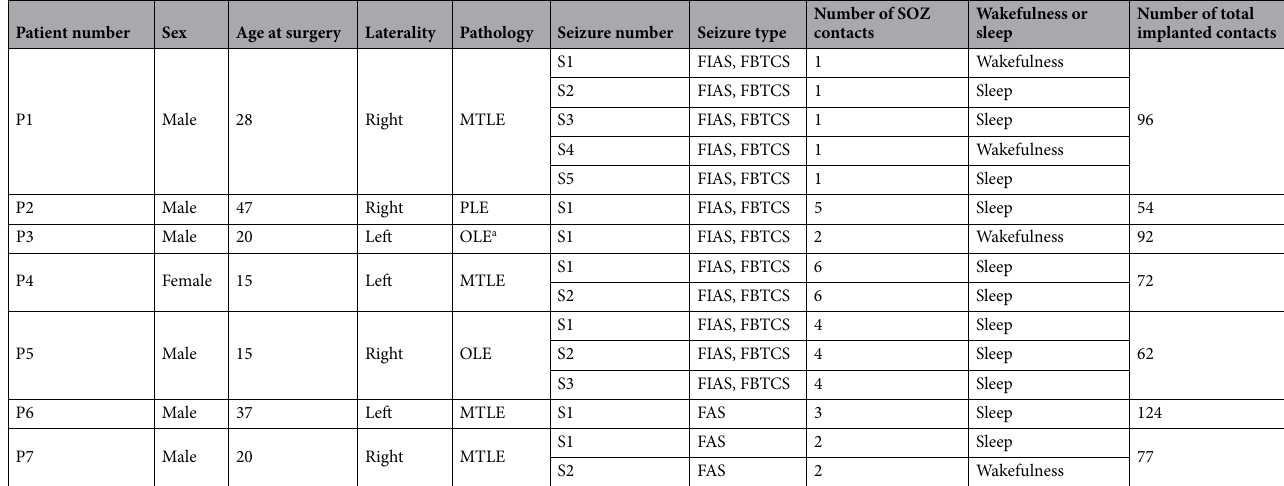
Table 1. Clinical profile of the enrolled patients. The seizure number is the serial number of seizures in each participant. SOZ, seizure onset zone; MTLE, mesial temporal lobe epilepsy; FIAS, focal-impaired awareness seizure; FBTCS, focal-to-bilateral tonic–clonic seizure; PLE, parietal lobe epilepsy; OLE, occipital lobe epilepsy; FAS, focal aware seizure. a Based on the presurgical examination, we suspected MTLE or OLE.